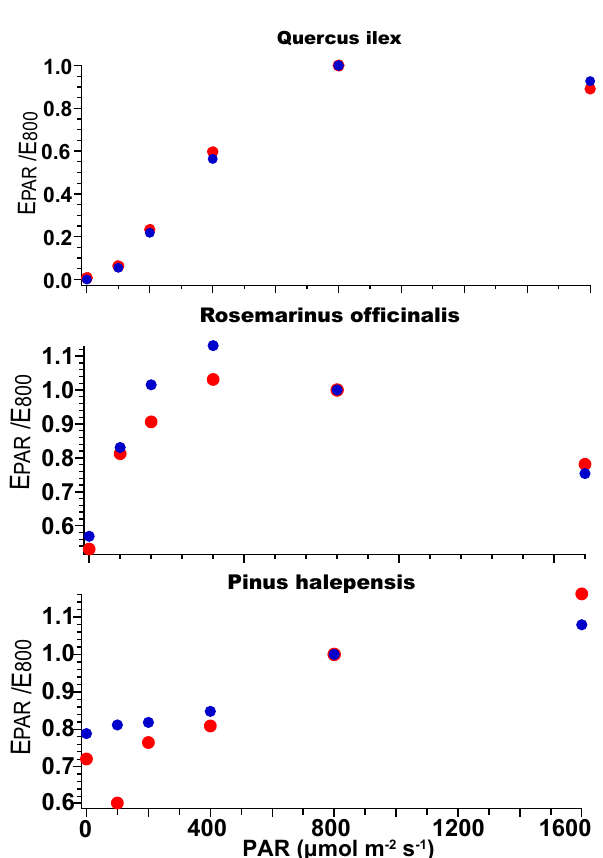
Fig. 4. An example of ( − )/( + ) - α -pinene emission which was nor- malized by dividing by emission at 800µmolm − 2 s − 1 from three selected plant species in dependency with light (at 30 ◦ C). The red points represent normalized ( − )- α -pinene emissions and the blue points show the normalized ( + ) - α -pinene